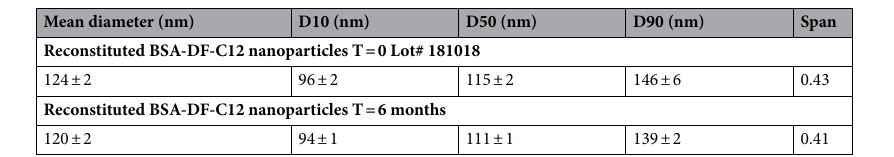
Table 4. Nanoparticle tracking assessment of reconstituted BSA-DF and BSA-DF-C12 nanoparticles 6 months post-lyophilisation. Data represents mean values ± standard deviation from measurement of at least three aliquots of